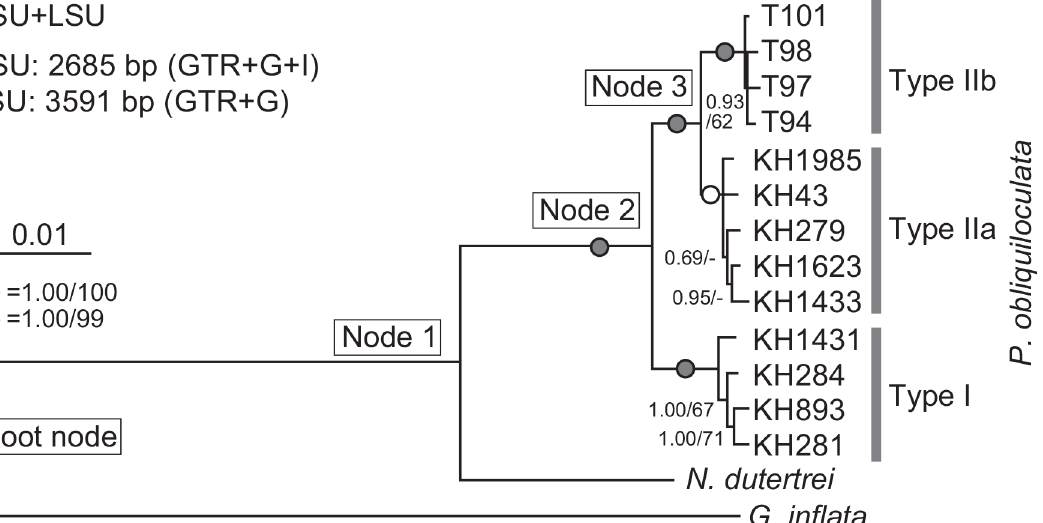
Fig 4. Bayesian phylogeny of the SSU + LSU rDNA sequences obtained from P . obliquiloculata and two outgroup species. Bayesian posterior probability (PP) and bootstrap values (BV) are shown at each node. The nodes used for divergence time estimations are named in enclosed boxes. Grey and white circles indicate high posterior PPs and BVs (PP/BV = 1.00/100 and PP/BP = 1.00/99, respectively).